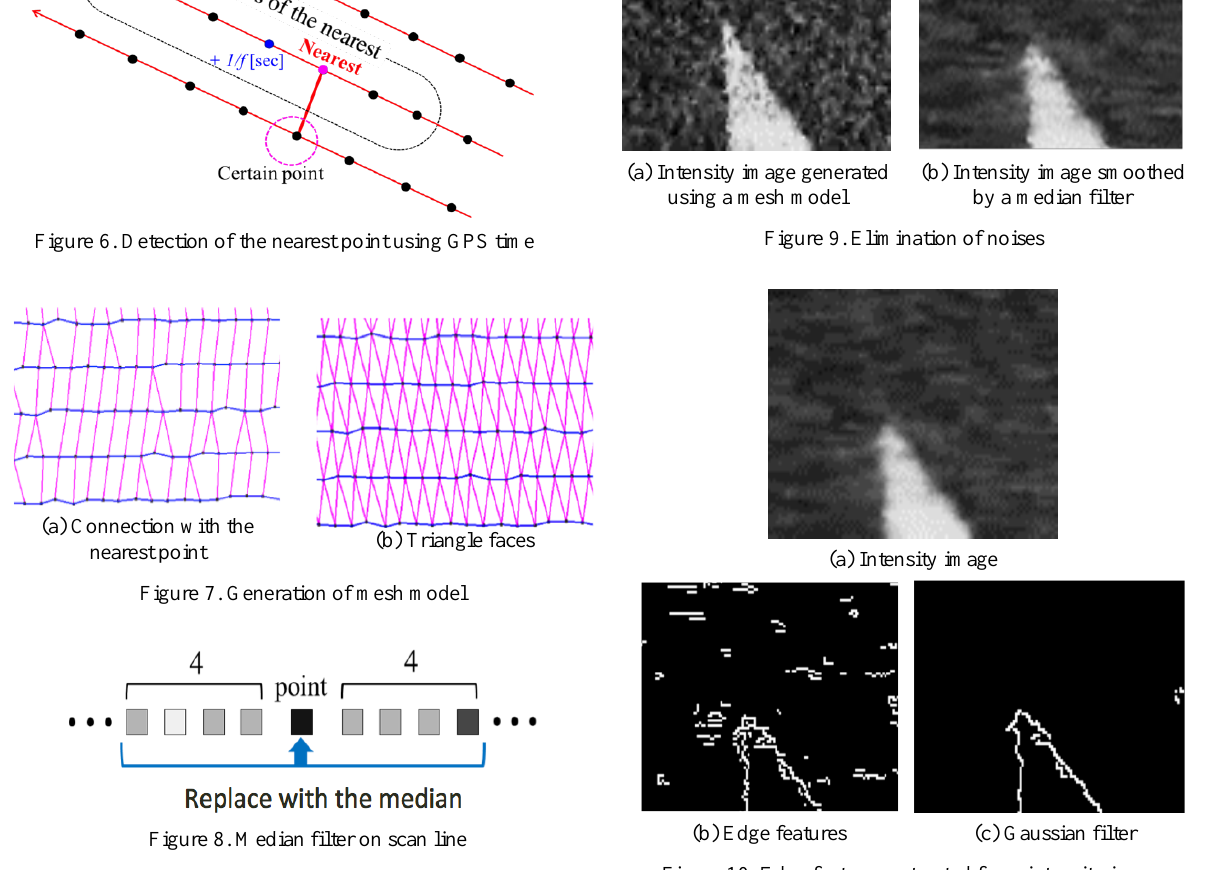
Figure 10. Edge features extracted from intensity